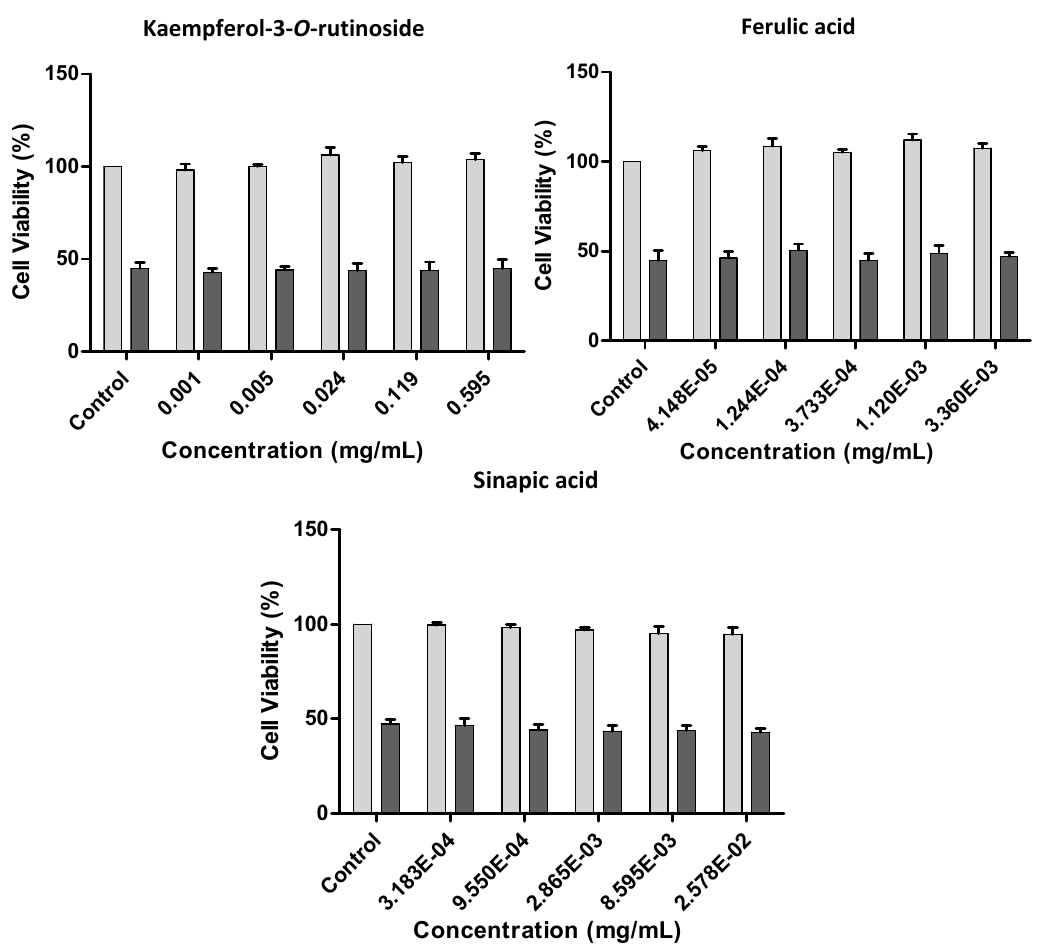
Figure 6. Effect of kaempferol-3- O -rutinoside, ferulic and sinapic acids on V79 cells viability with and without H O -induced oxidative stress. Values show mean ± SE (n = 2 2